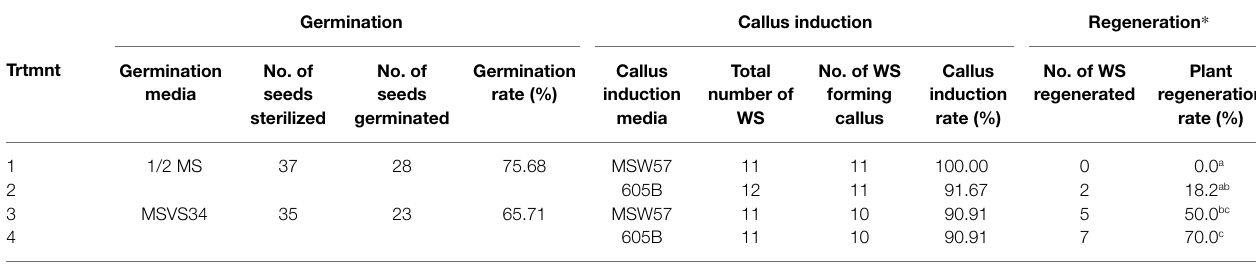
TABLE 1 | Summary of plant regeneration using different germination and callus induction